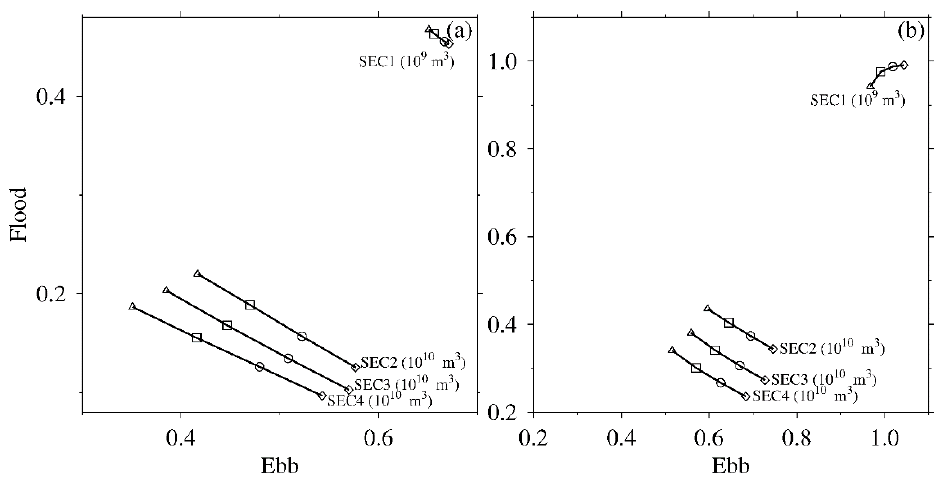
Figure 17. Flood and ebb water fluxes across the sections during neap tide ( a ) and spring tide ( b ) in EX8 (triangles), EX9 (squares), EX10 (circles) and EX11